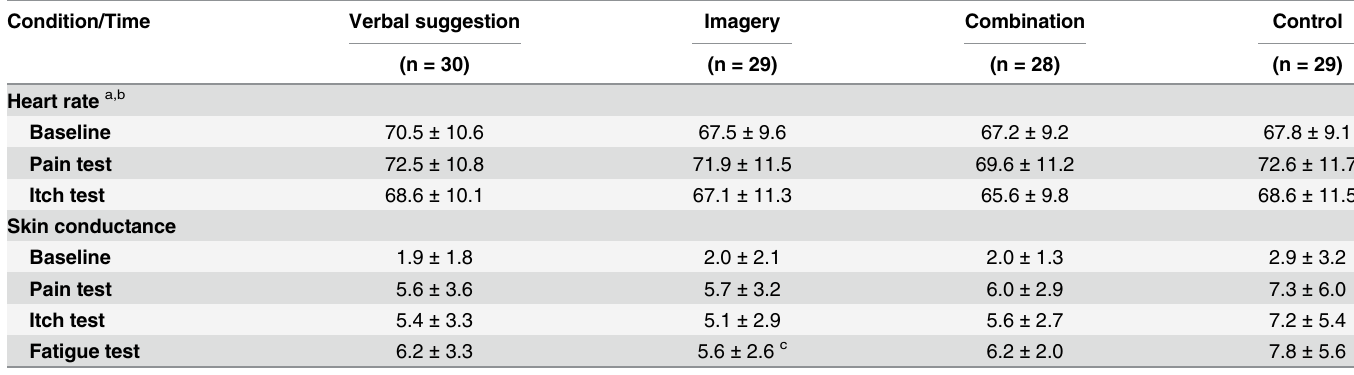
a Heart rate during the fatigue test is not reported here because it was tailored during this test